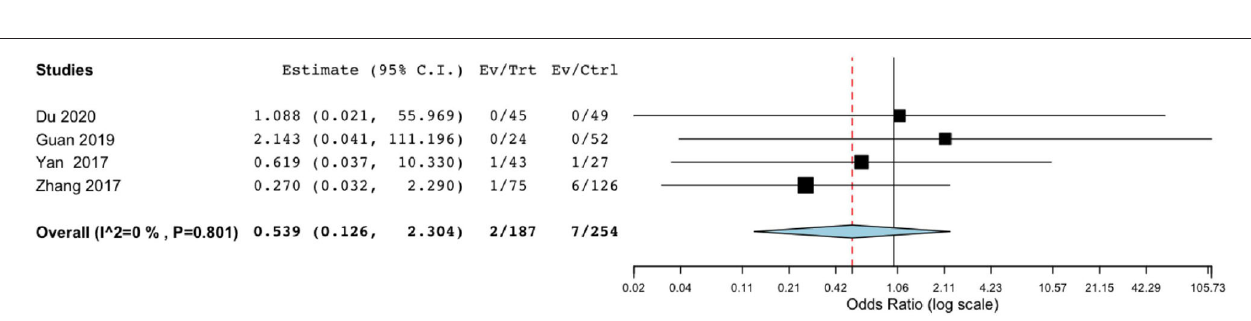
FIGURE 3 | Risk of postoperative complications in endoscope-assisted surgery and BHC groups. (OR of 0.249, 95%CI, 0.07–0.882, P = 0.031, I 2 = 71.87 % ).